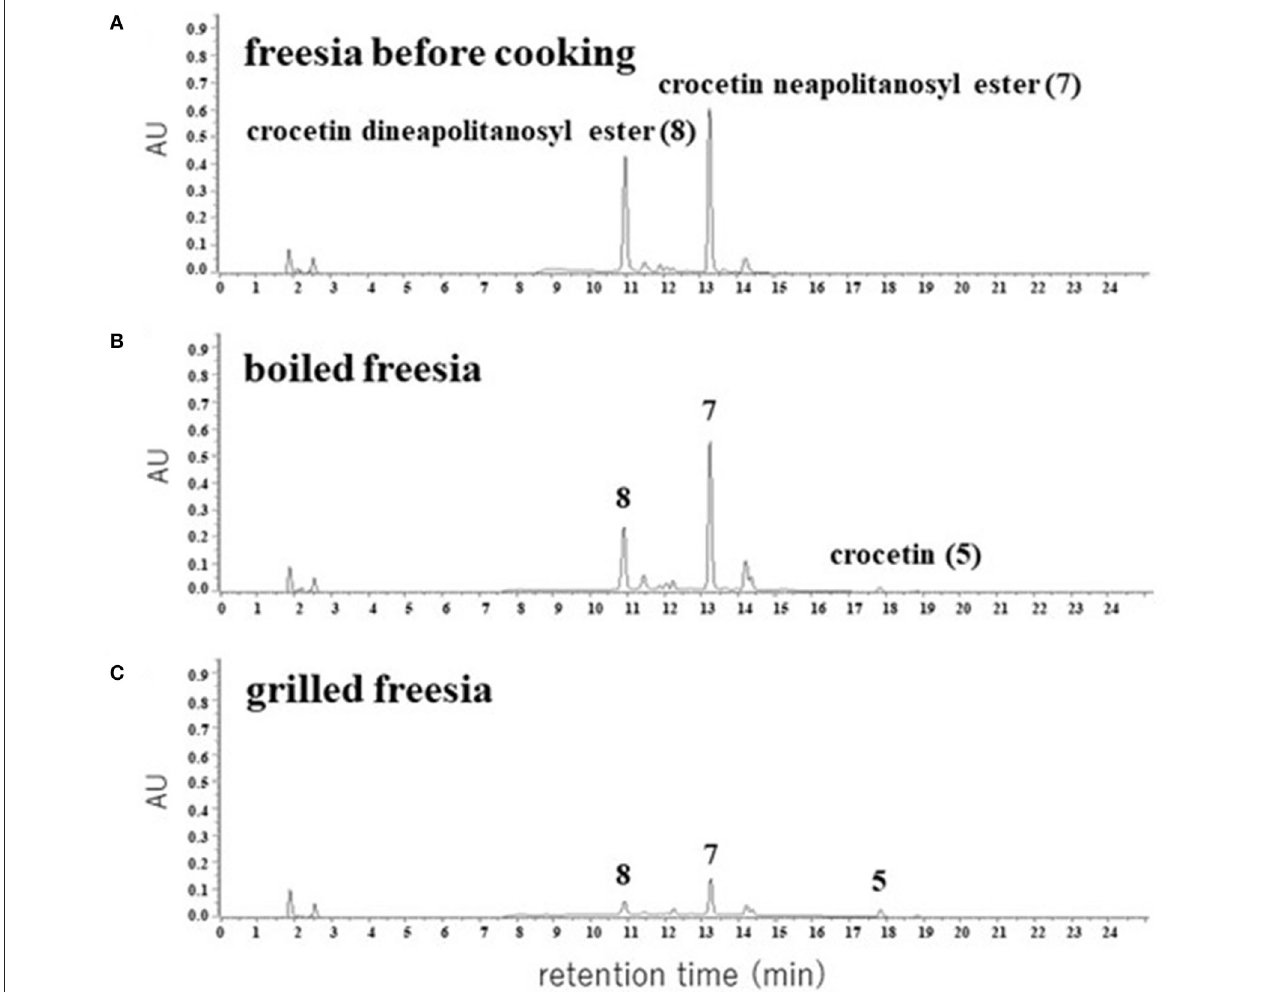
FIGURE 7 | HPLC chromatograms of apocarotenoids extracted from the yellow petals of freesia “Kayak” (A) and their cooked materials (B,C) . The detection wavelength was 440nm.